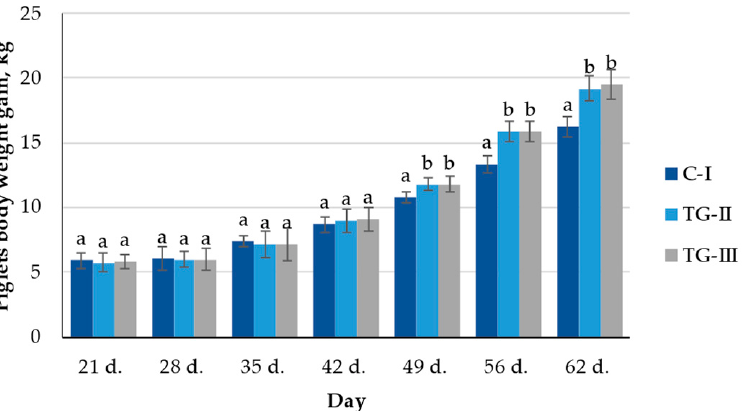
Figure 3. Piglets’ body weight (BW) gain (kg) ( a,b different letters indicate differences among treatments, p < 0.05; C-I—control group TG-II—treatment group with extruded–fermented wheat bran addition; TG-III—treatment group with sugar beet pulp).